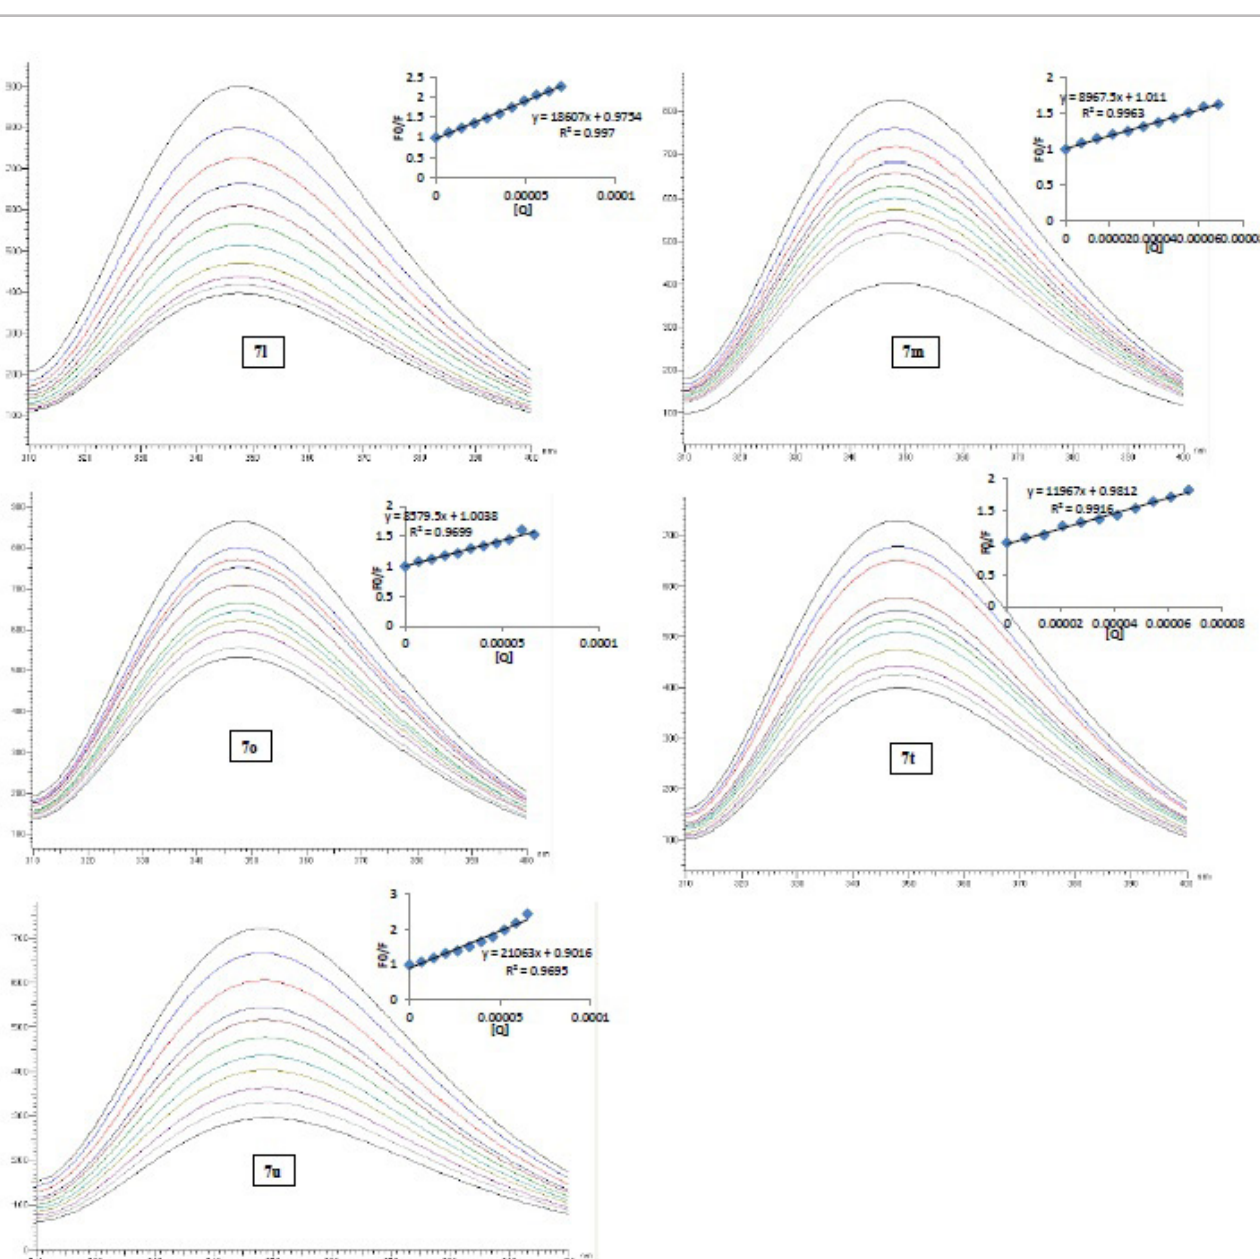
FIGURE 4 - Fluorescence emission spectra of BSA and different amounts of selected compounds ( 7l , 7m , 7o , 7t , 7u ) at 295 nm and 298 K (inset graph corresponding to the Stern-Volmer